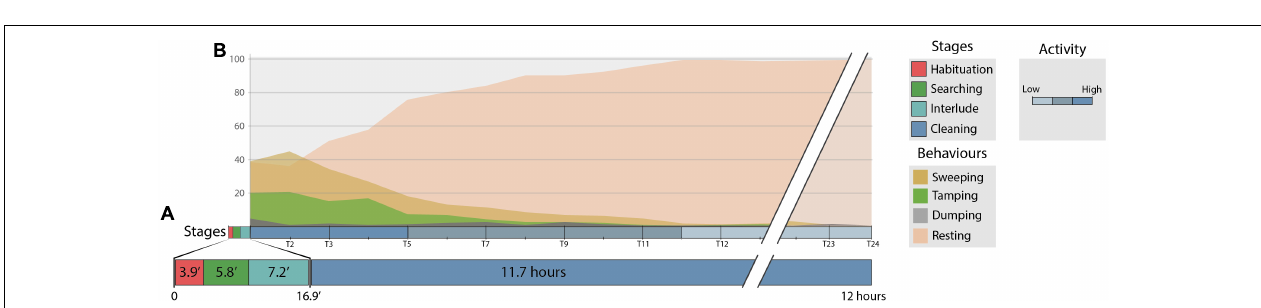
FIGURE 6 | Number of anemones Bartholomea annulata that displayed successful or failed retraction response to a simulated aggression in each of three experimental treatments: (i) anemone in a shelter with sand and two snapping shrimps (BSA); (ii) anemone in a shelter with sand but without shrimp (BS0) and (iii) anemone alone in its shelter, i.e., without shrimp or sand (B00).